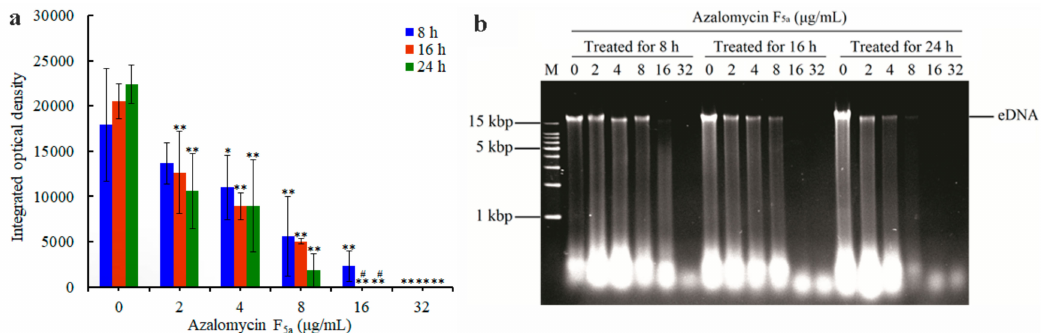
Figure 6. Influence of azalomycin F 5a on the eDNA in S. aureus mature biofilm. ( a ) Comparing the eDNA content of di ff erent azalomycin F 5a -treated groups with that of the blank control at the same time points, with * or ** indicating significant di ff erences at p < 0.05 and p < 0.01, respectively. Symbol # indicates a significant di ff erence ( p < 0.05) when compared the eDNA contents within the same treatment groups at di ff erent time points. ( b ) Representative agarose gel electrophoresis of eDNA in S. aureus mature biofilm treated with 2.0, 4.0, 8.0, 16.0 and 32.0 µ g / mL of azalomycin F 5a for 8, 16 and 24 h, respectively. The optical density of the eDNA band, indicating the relative content of the eDNA, was determined using ImageJ software, and the results were presented as the mean ± SD values of three